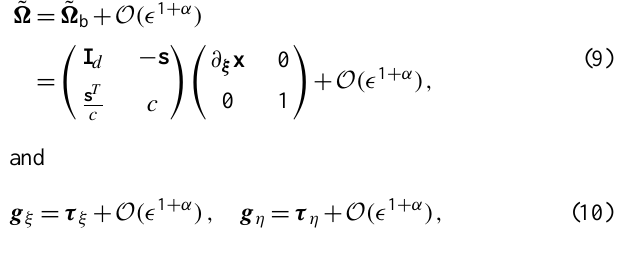
Fig. 1. The Cartesian ( x,y,z ) and arbitrary ( ξ,η,ζ ) coordinates.